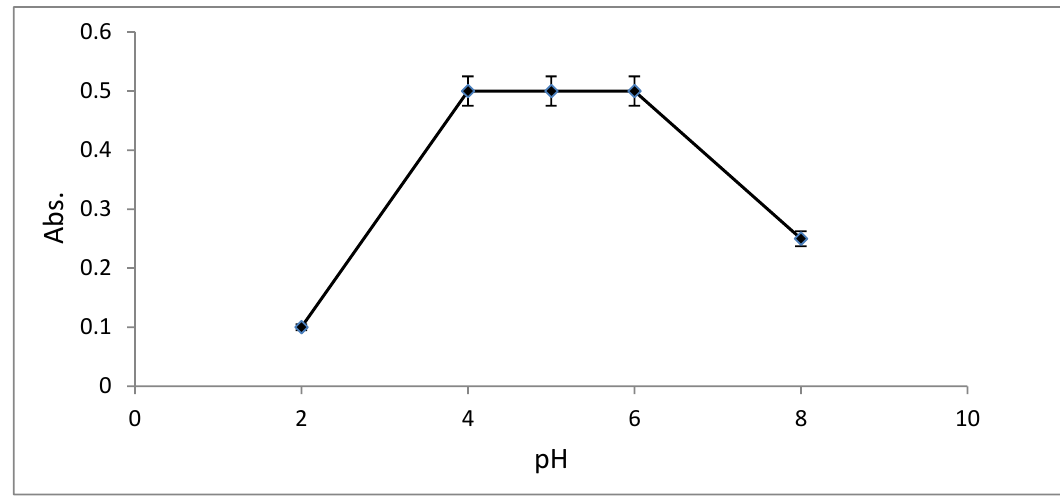
Figure 9. Influence of solution pH on the absorbance of [Cu(L)(NO 3 )(H 2 O) 2 ] . H 2 O at λ max = 434 nm. Copper(II) concentration = 2 μg mL −1 ; [AMT] = 1.20 × 10 −4 M.